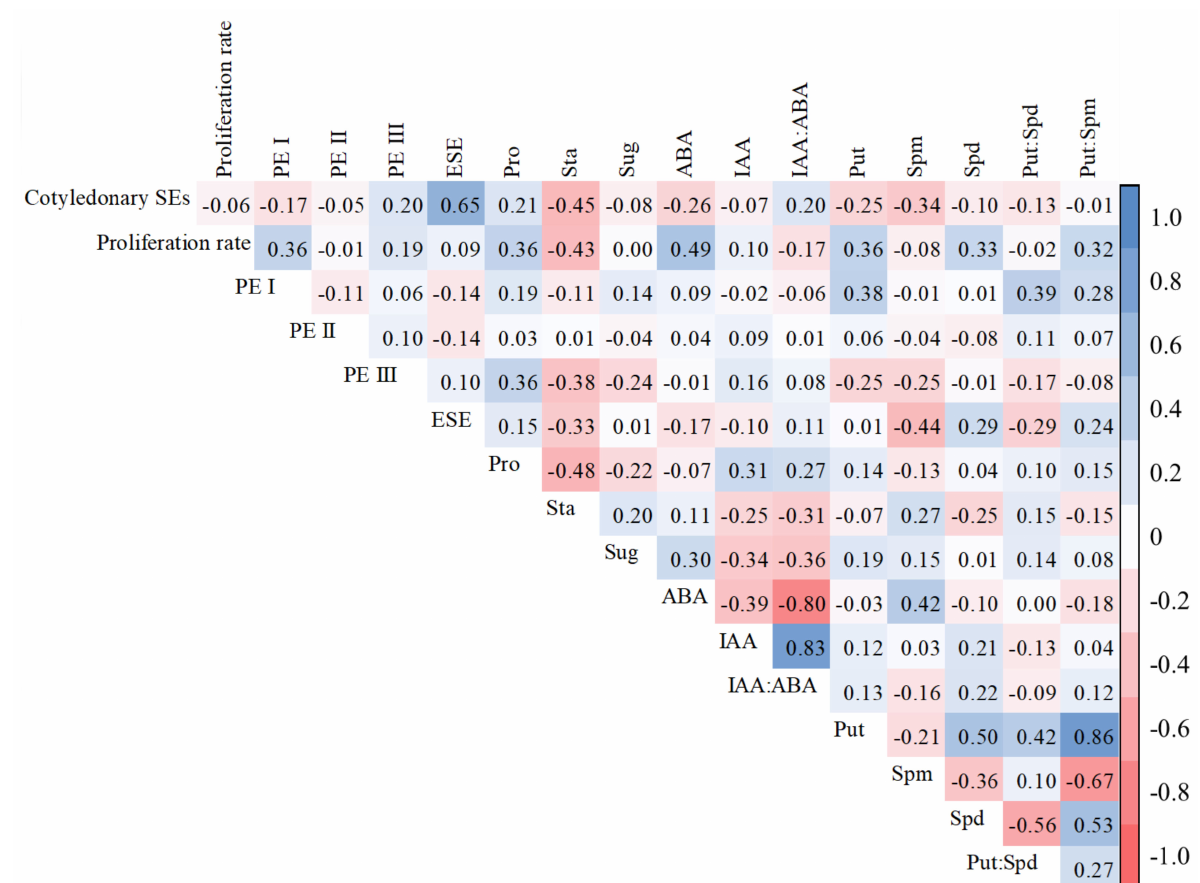
Figure 4. Differences in FW and proliferation rate of different cell lines of P. koraiensis after 14 days of proliferation. ( a ) R cell lines; ( b ) B cell lines. Different letters above the column indicate significant differences at the p < 0.05 level.